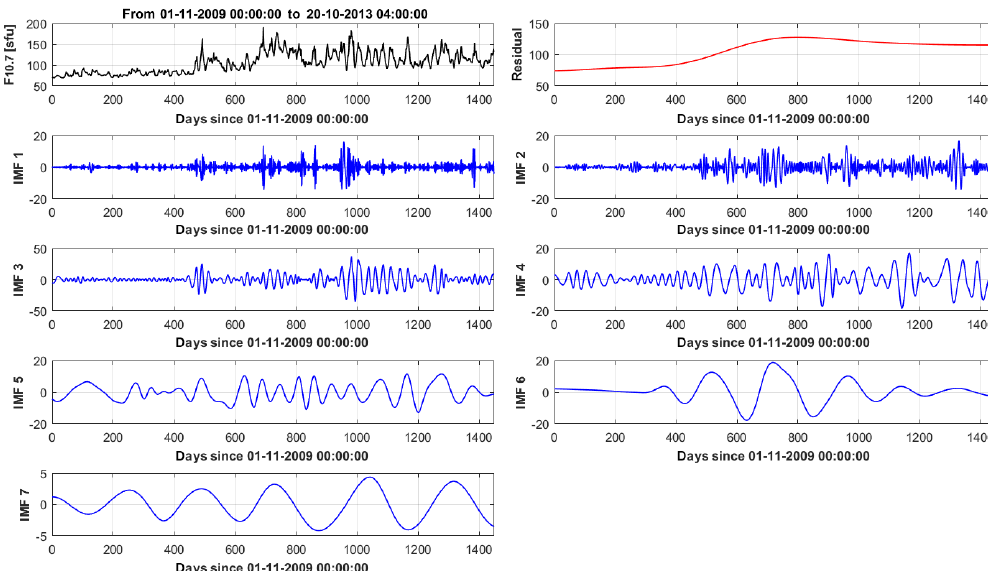
Figure 8. EMD decomposition for the F10.7 solar radio flux. Top row: original signal and trend. From first row: successive orders of basis functions (IMFs). Solar flux unit: sfu.